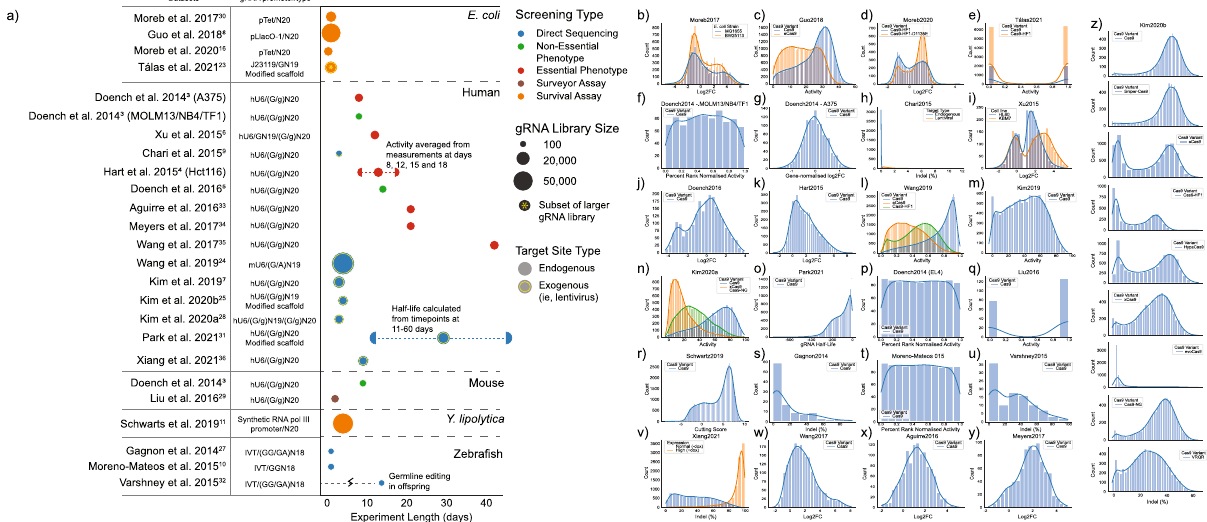
Fig. 2 Summary of the datasets included in this analysis. a Datasets collectively represent a diverse set of expression methods, experiment durations, species, selection types, gRNA library sizes, and target types. The bars on some data points represent the range of days that activity in those datasets has been calculated from. b – z These datasets cover a broad range of activity distributions, including moderate to extremely binary distributions, normal distributions, and completely uniform distributions, based on how activity was measured and data were processed. All datasets are shown with higher gRNA activity represented by larger numbers. In some cases, that required inverting the scale of activity as described in the Methods (namely, b , d , o , w , x , and y